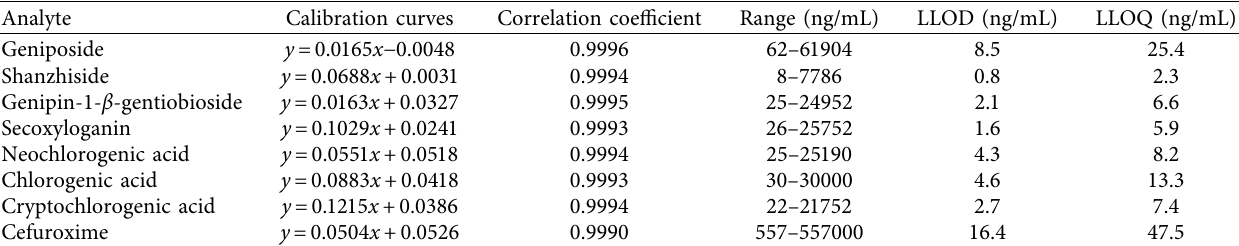
Table 3: The regression equations, linear ranges, LLODs, and LLOQs of the seven analytes and cefuroxime. Analyte Calibration